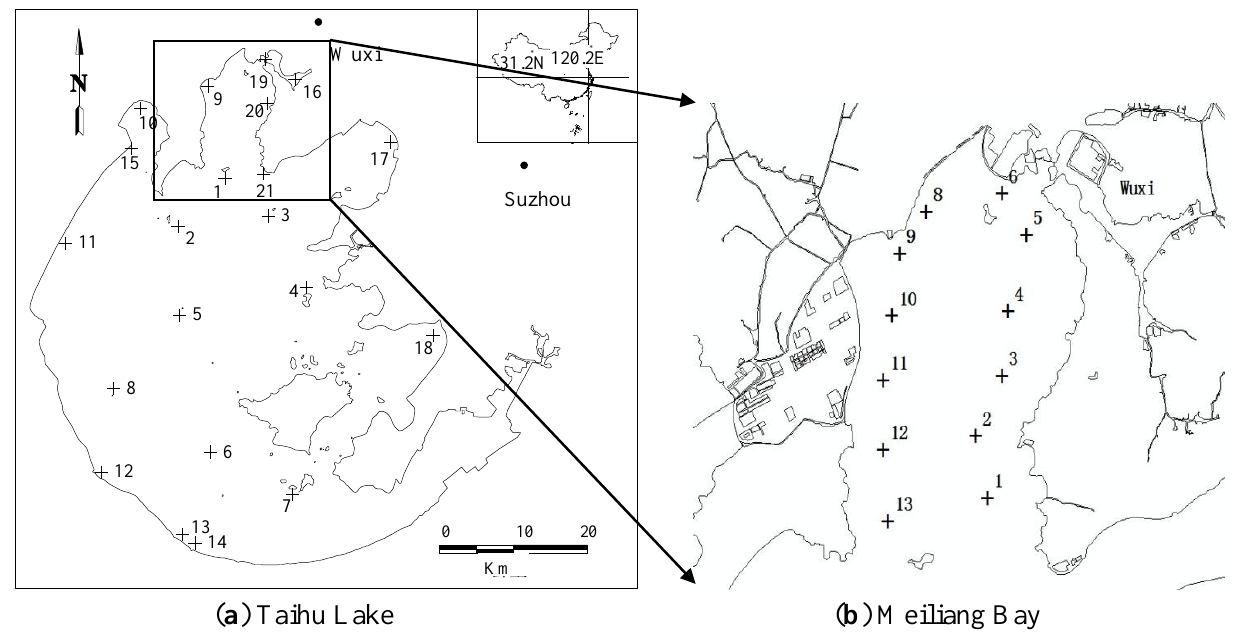
Figure 1. Sample distribution of Taihu Lake in ( a ) July-August of 2004 and 2005 and ( b ) March of